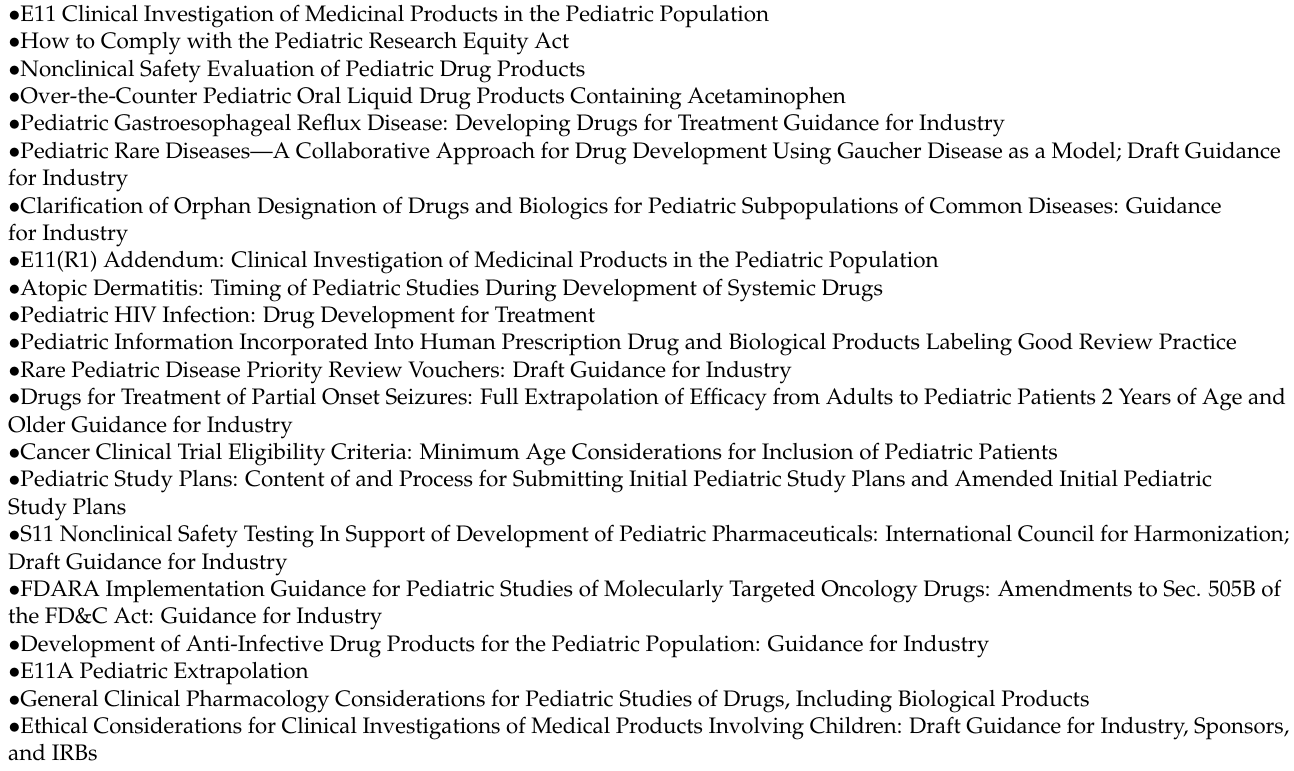
Table 1. US-FDA Pediatric Guidance Documents,